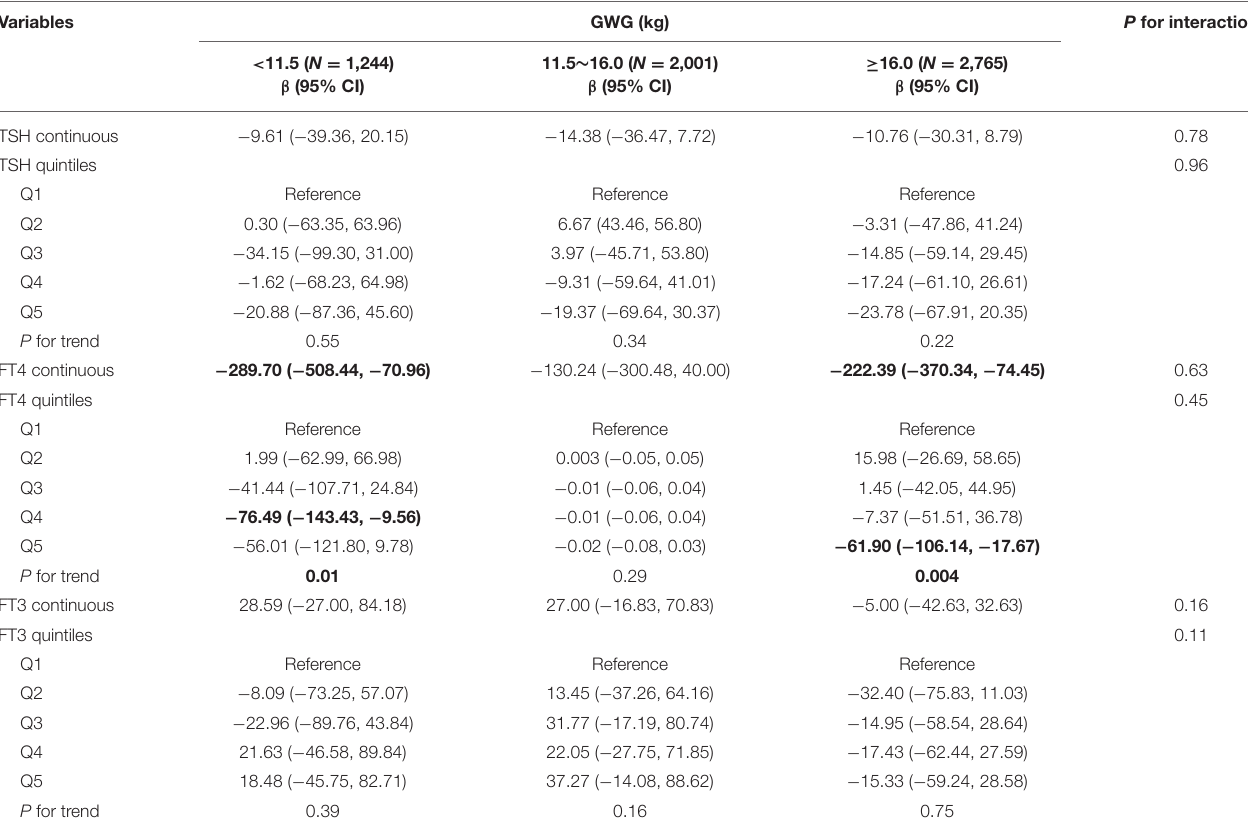
TABLE 3 | Adjusted regression coefficients a for birth weight associated with maternal thyroid parameters during early pregnancy stratified by GWG among normal weight women ( N = 6,010).